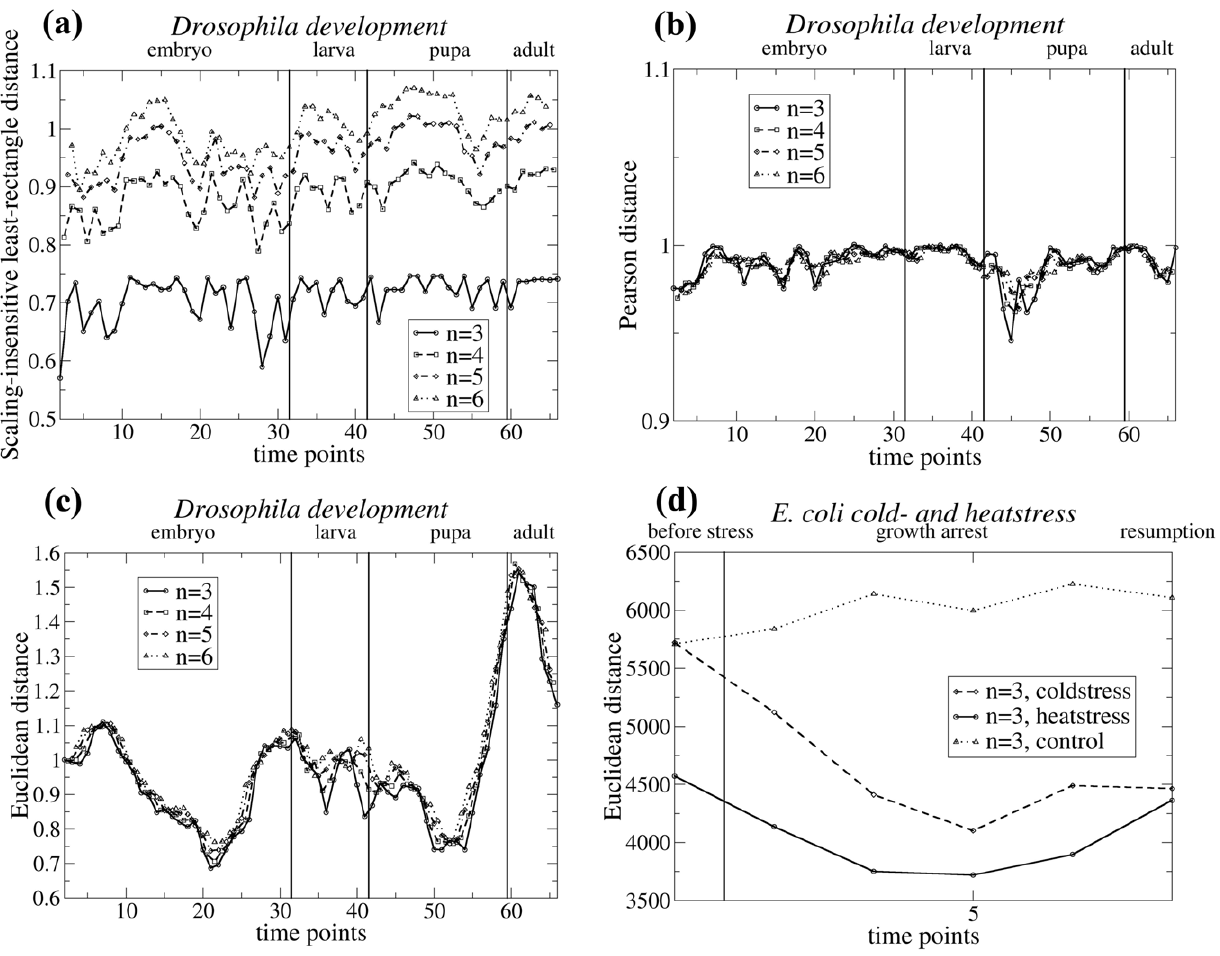
Figure 1. Average distance (cid:2) DD between profile segments of length n , as a function of the time points k , for gene expression profiles nk obtained from DNA microarray experiments. The values of n are indicated on the figures, as well as the developmental phases. Note that the values of the distances appear sometimes very different in the different graphs; this is due to the fact that some gene expression profiles ~ XX m ( t ) borrowed from the literature are scaled and/or expressed relative to a reference sample and others not (see eq. (1)). Different distance measure are : (a) scaling-insensitive variant of the least-rectangle distance D S ; (b) Pearson distance D P ; (c, d) Euclidean distance D E . These used to compute (cid:2) DD nk distances are computed on the DNA microarray time series monitoring: (a–c) Drosophila development; (d) unstressed E. coli (used as a control).